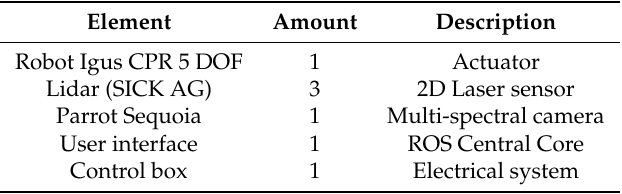
Figure 2. Structure with the robot arm positioned in the center of the platform. ( a ) mobile platform assembled, ( b ) robotic platform—on field. Source: Author. Table 1. Elements and components of the mobile